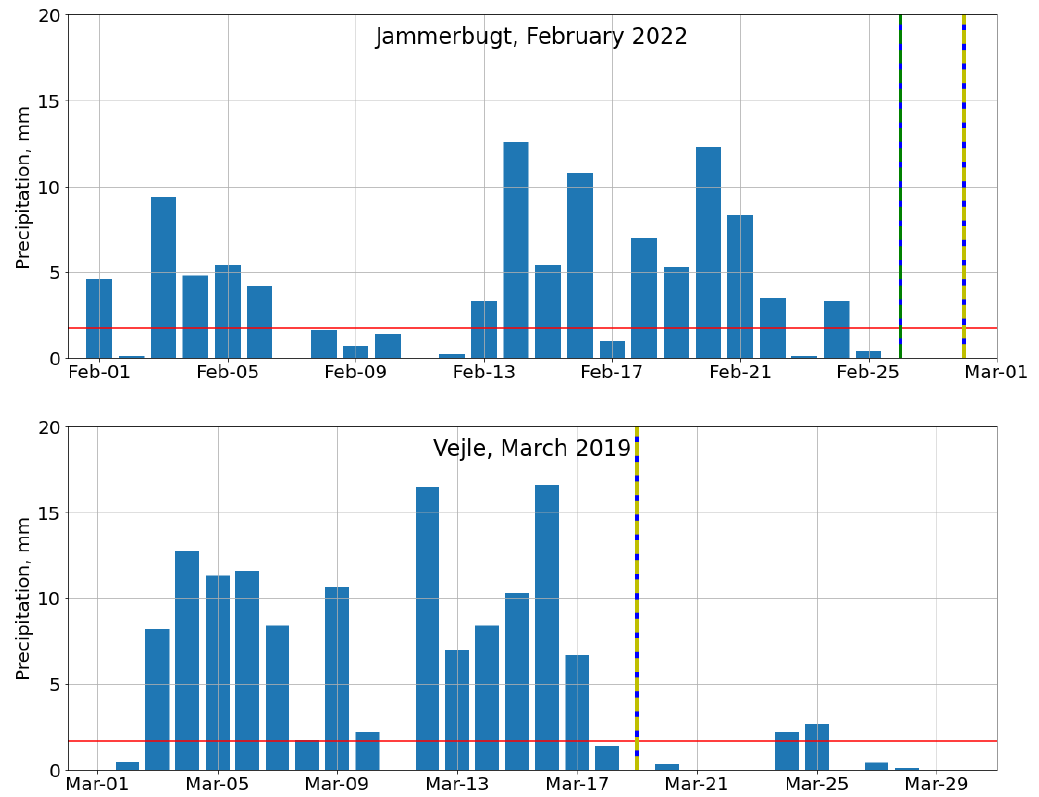
Figure 2. Daily rainfall time series for Jammerbugt and Vejle municipalities in February 2022 and March 2019, respectively. Red lines indicate long-term average precipitation. Data provided by the Danish Meteorological Institute through their “Vejrarkiv” web interface (www.dmi.dk/vejrarkiv/ accessed on 16 November 2022). Vertical blue lines indicate dates of UAS thermal surveys, vertical green lines indicate Sentinel-1 acquisitions, and vertical yellow lines Sentinel-2 acquisitions.